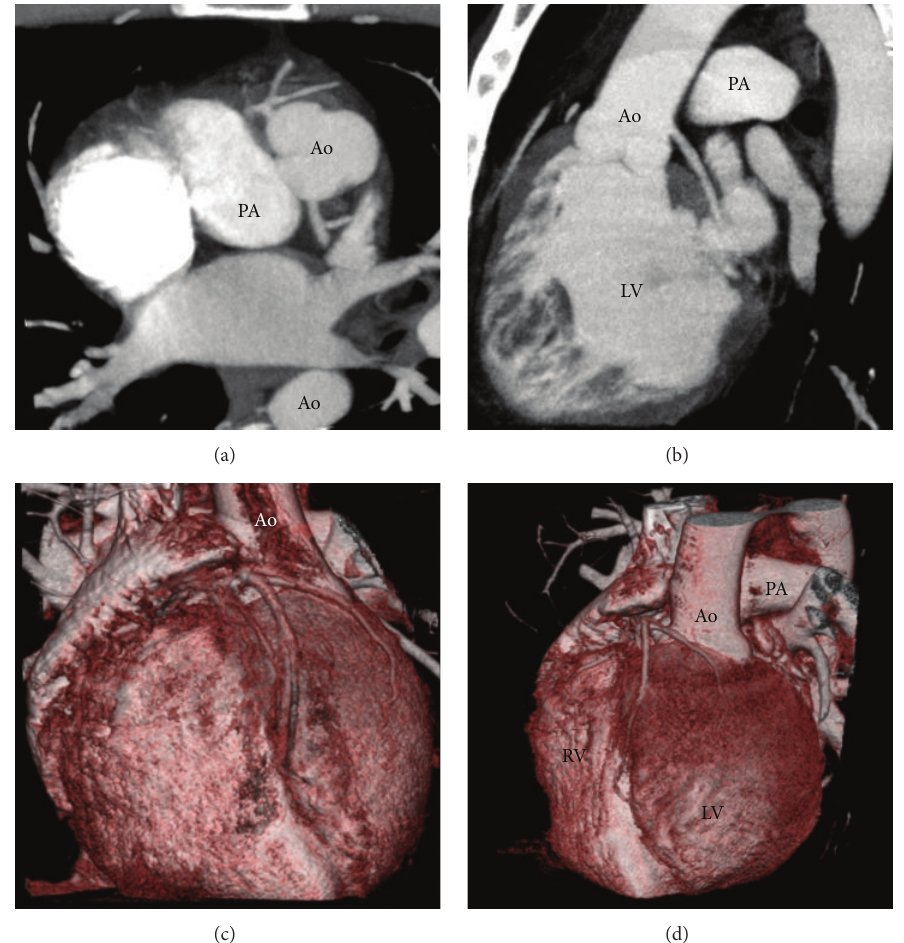
Figure 2: Paraxial (a) and parasagittal (b) maximum intensity projection reconstruction from cardiac CT scan, demonstrating the anomalous site of the coronary ostia as well as the malposition of the great arteries, confirmed by 3D volume-rendered reconstruction ((c),